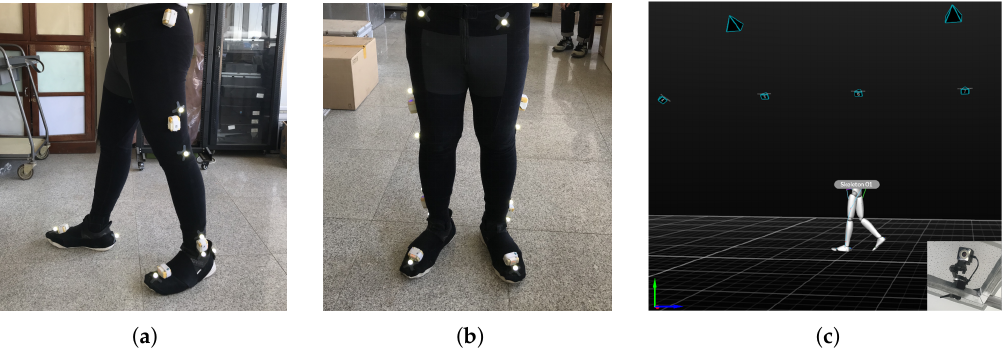
Figure 4. Sensor setup during gait experiments, with optical tracking markers and inertial measurement units (IMUs) attached to the subject; ( a ) Lateral view; ( b ) front view; ( c ) optical motion capture equipment: Software and